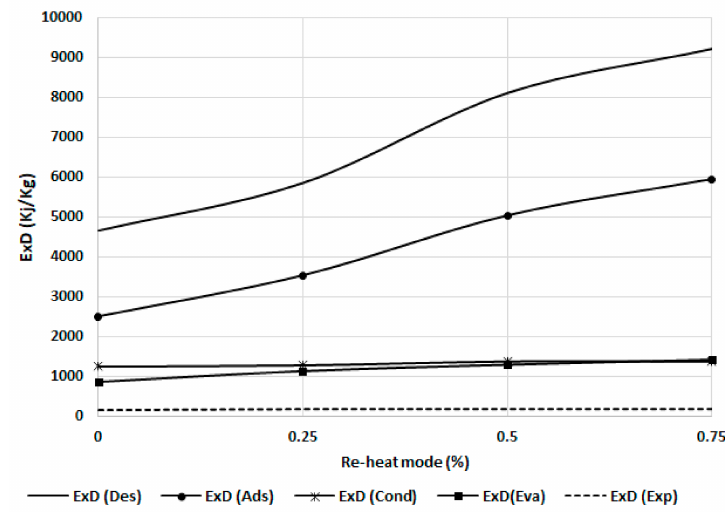
Figure 13. Exergy destruction in the chiller components at different reheating modes.